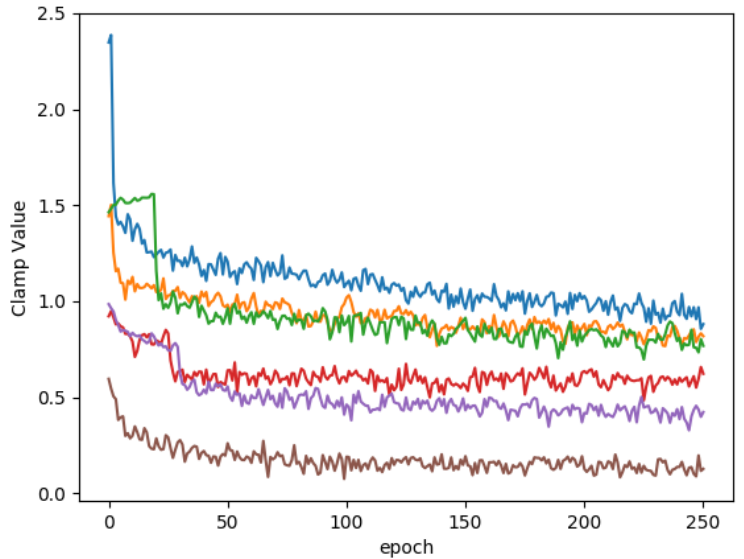
Figure 2. Activation clamp values during ResNet-18 training on CIFAR10